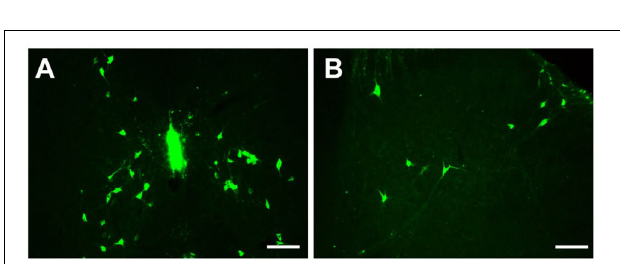
FIGURE 10 | Distribution of neurons labeled by CB in the spinal cord (A,B) . Scale bar = 100 µ m.